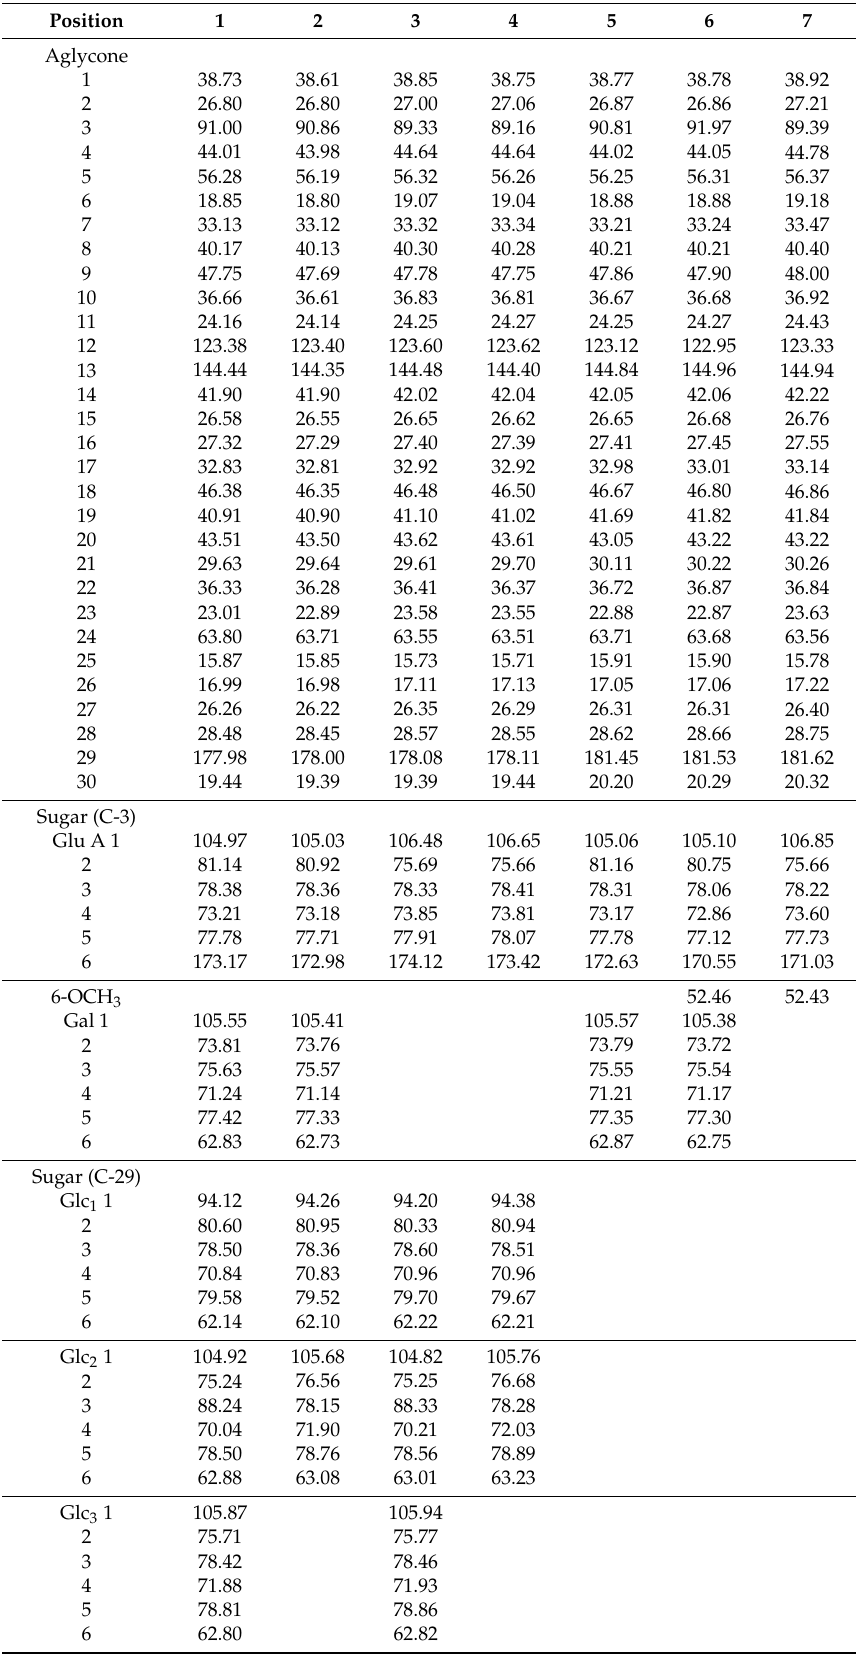
Table 2. 13 C NMR Data for Compounds 1 – 7 in Pyr- d 5